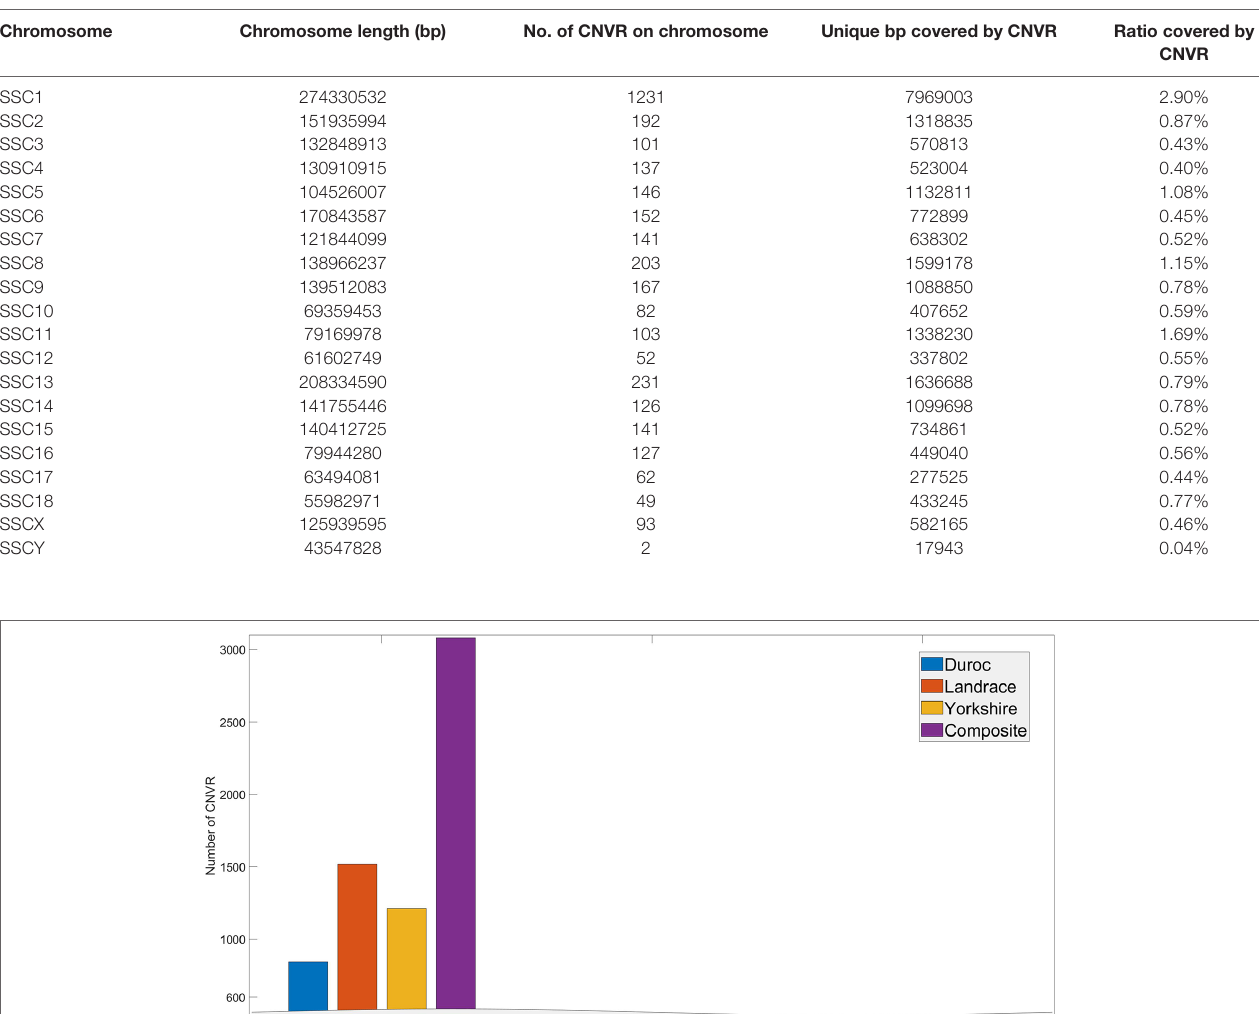
TABLE 1 | CNVR distribution across the genome. Chromosome Chromosome length (bp) No. of CNVR on chromosome